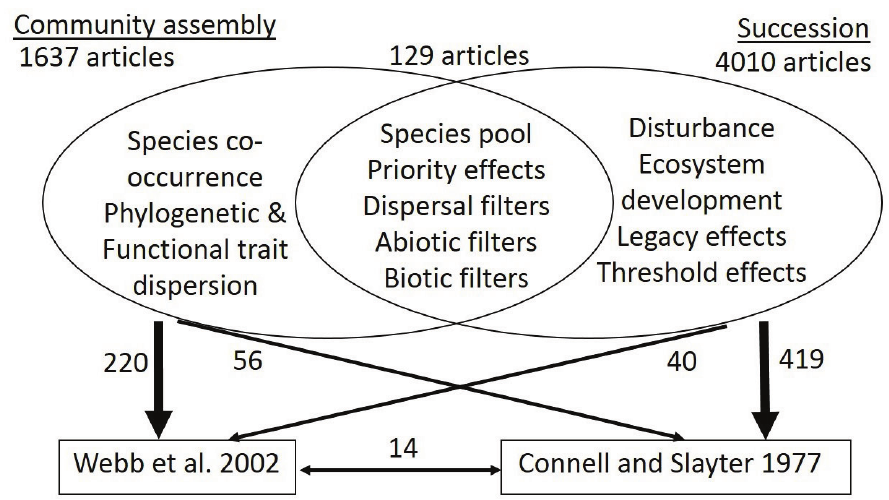
Figure 1. Examining published papers (as searched on Web of Science) that use “community assembly” versus “succession” as key words shows little cross-pollination. Venn diagram depicts typical associated concepts and shows that few articles use both key words. We chose one highly cited “community assembly” paper 42 and one highly cited “succession” paper 2 ; both papers are equally cited (~1000 each), with only 14 papers citing both. Of the “community assembly” papers, 220 cited Webb et al. 42 and 56 cited Connell and Slayter 2 . Of the “succession” papers, 419 cited Connell and Slayter 2 and 40 cited Webb et al. 42